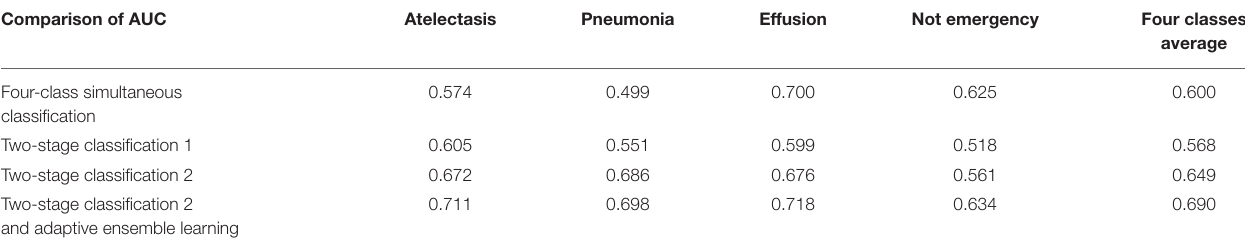
TABLE 1 | Accuracy comparison of four